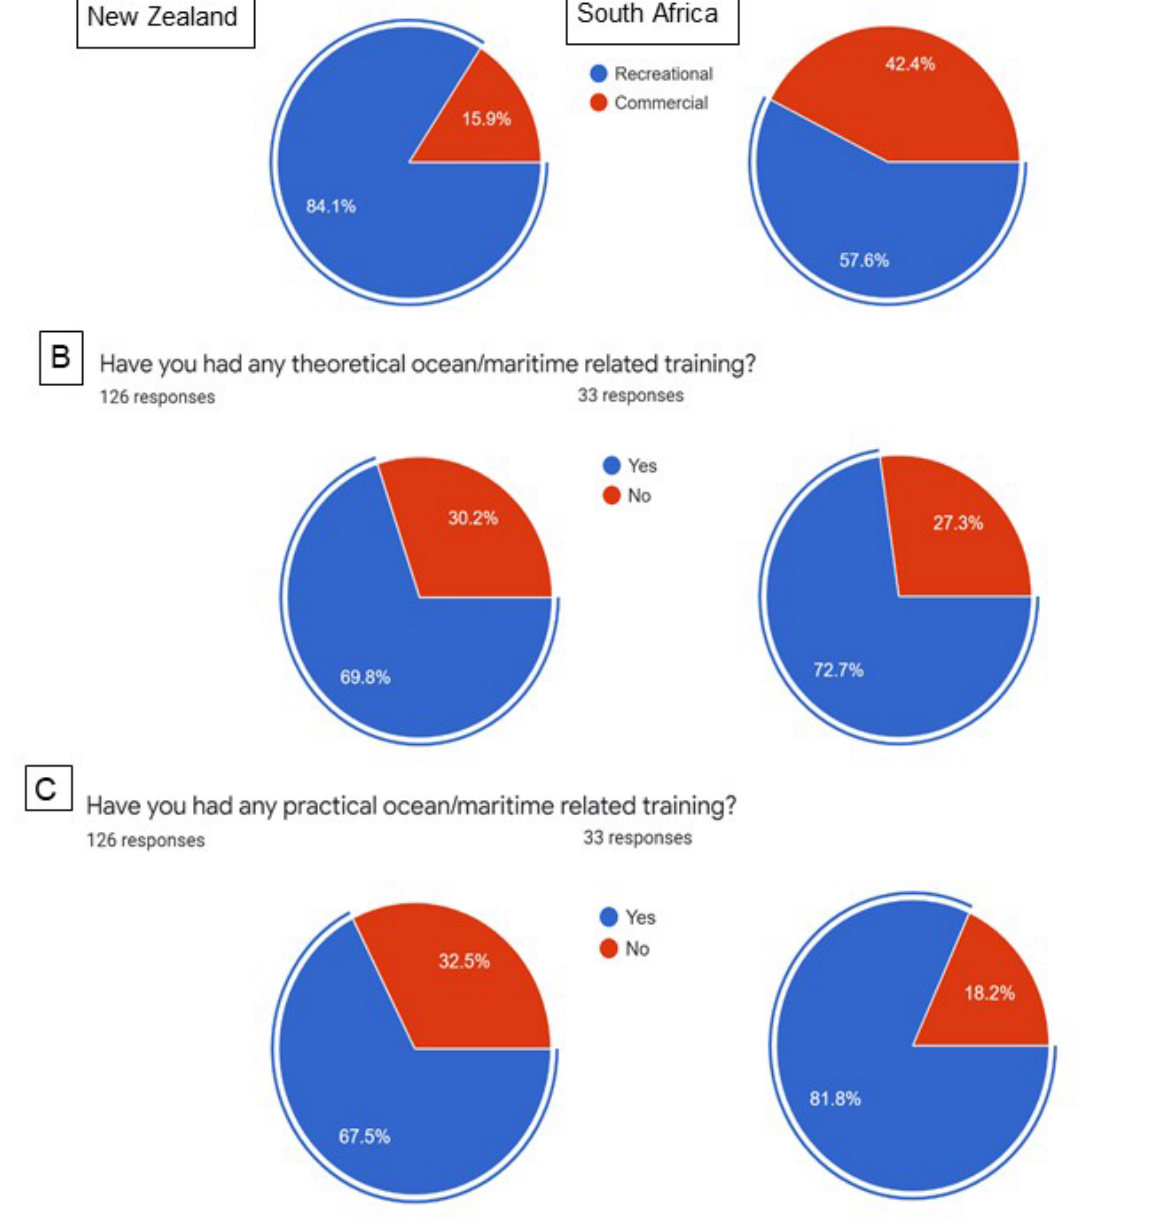
Figure A1. Summary of demographic questions related to the present study. Here questions A to C are given.